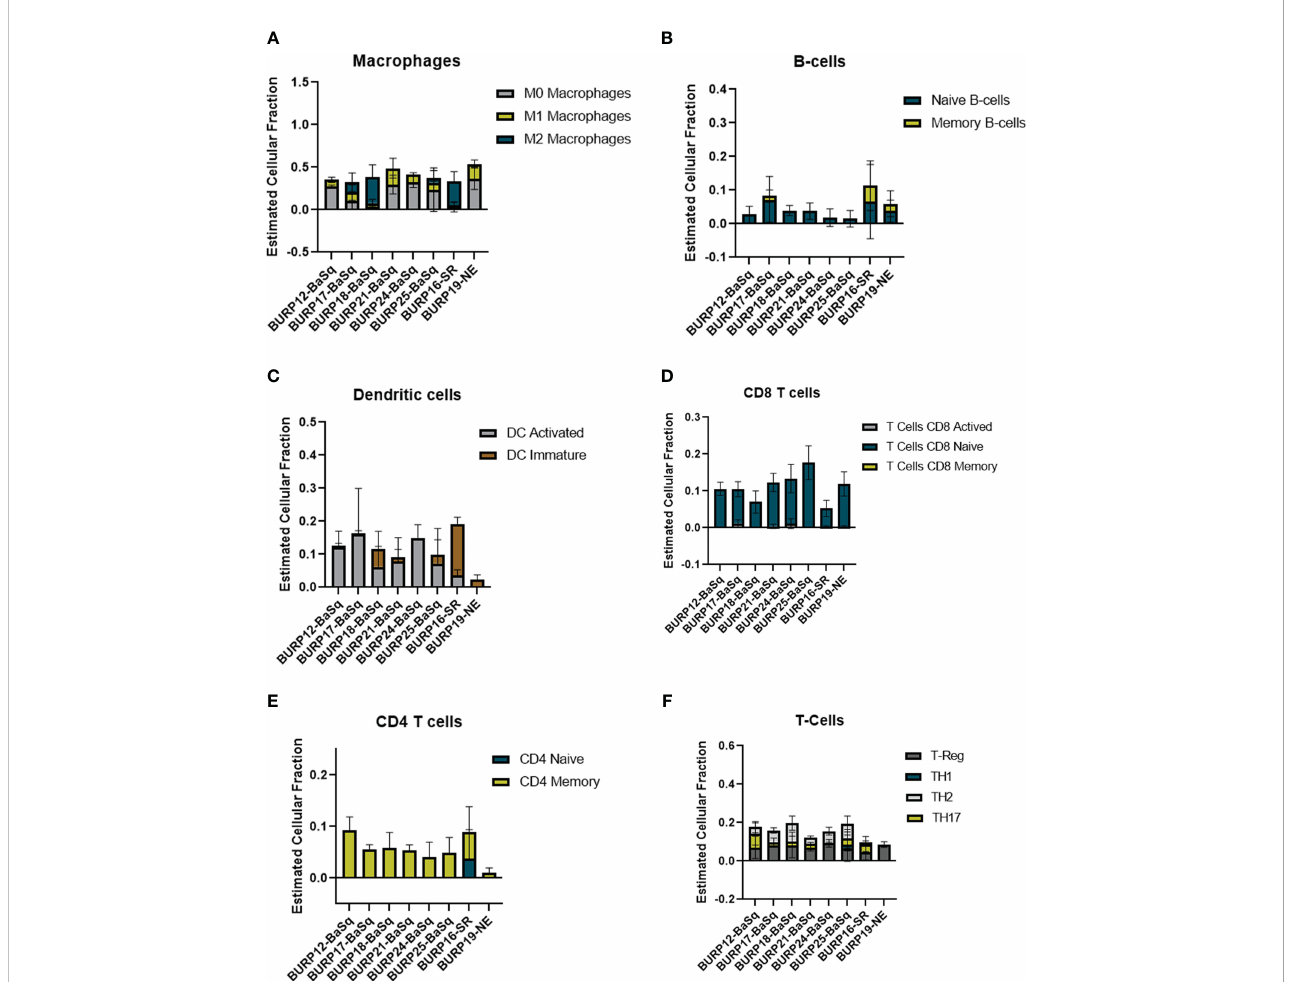
FIGURE 7 Comparison of the estimated fraction of different immune populations in different BURP tumor lines lines obtained by CIBERSORT. (A) polarized forms of macrophages. (B) naïve and memory B-cells. (C) DC immature and activated. (D) naïve, activated, memory CD8Tcells (E) naive and memory CD4 T-cells. (F) CD4+ T cell helper